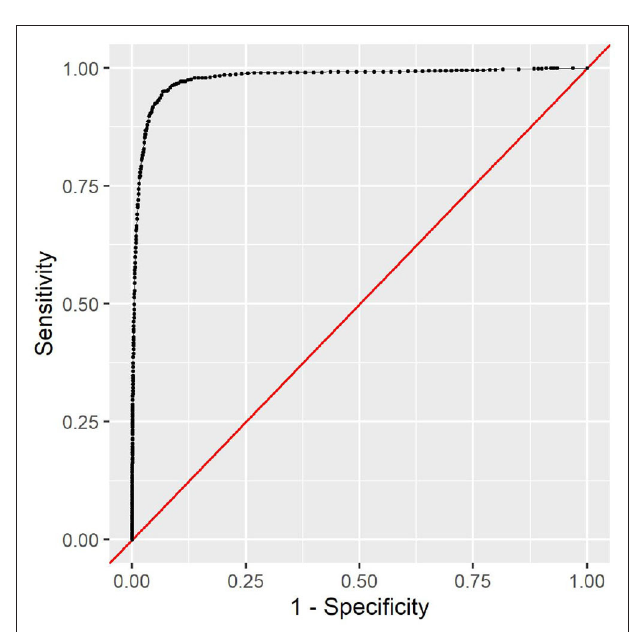
FIGURE 5 | The receiver operating characteristic of the minimal model.